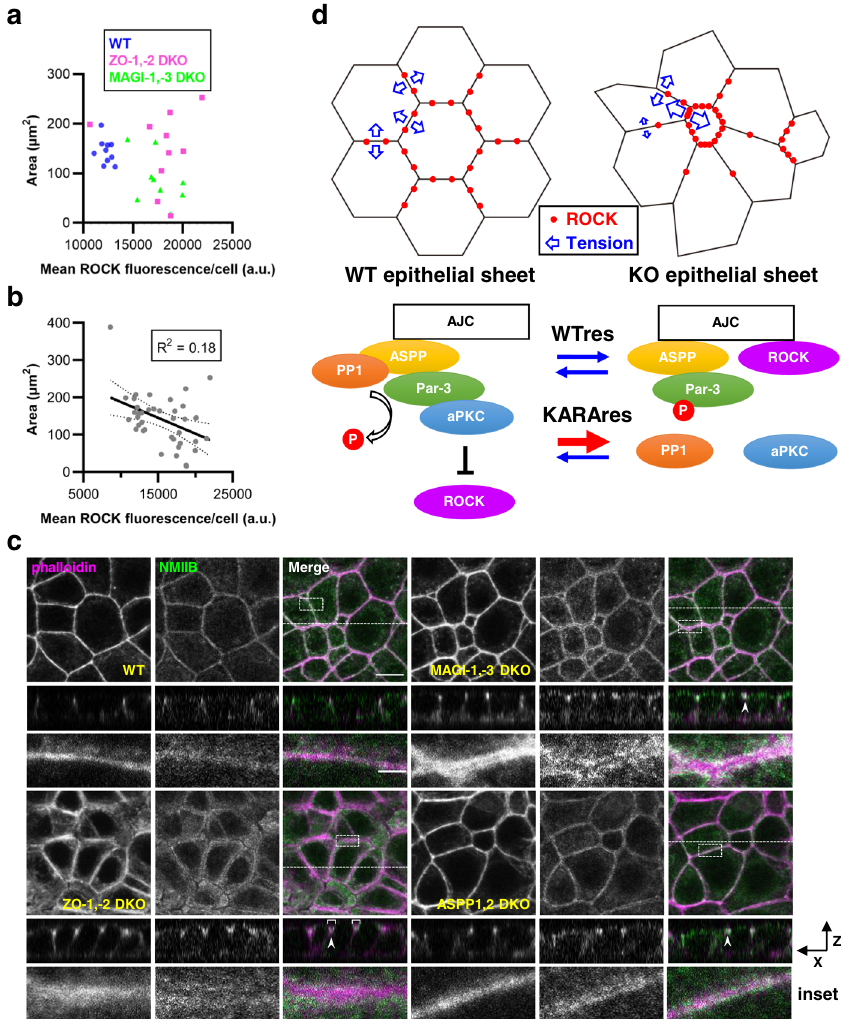
Fig. 5 Antagonism of ROCK activity at AJC requires scaffolding of PP1-Par-3 interaction by ASPP2 to stabilize the Par-3-aPKC complex. a Plot of cell area against ROCK1 immuno fl uorescence for WT, ZO-1,-2 DKO and MAGI-1,-3 DKO cells. Representative images were shown previously in Figs. 1h and 2f. Maximum intensity projections of apical sections determined by α -catenin enrichment were segmented. Data were from ten contiguous cells for each condition. b Plot of cell area against ROCK1 immuno fl uorescence from data in F collated with additional measurements. Solid line is the interpolated linear regression with the 95% con fi dence intervals shown by the dotted lines. c Representative immuno fl uorescence images of WT, ZO-1,-2 DKO, MAGI-1,3 DKO and ASPP1,2 DKO cells stained for NMIIB. Orthogonal views of the cross-section and insets indicated by the white dashed lines and boxes, respectively are shown below. Arrowheads show well-developed NMIIB fi laments alongside the junctional actin network. Brackets show NMIIB expansion to the subapical region. Scale bar, 10 μ m (inset, 2 μ m). d Proposed model for normalization of intercellular tension in the epithelial cell sheet by MAGIs. Source data are available in Supplementary Data